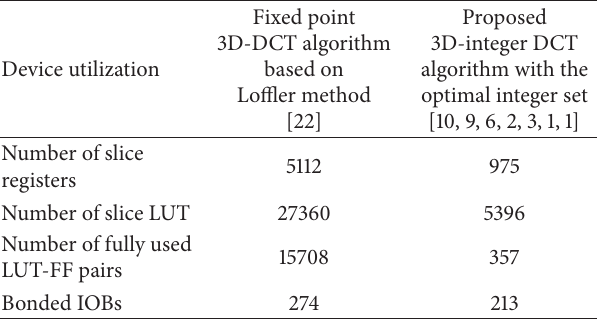
Table 4: Comparison of device utilization summaries of the pro- posed